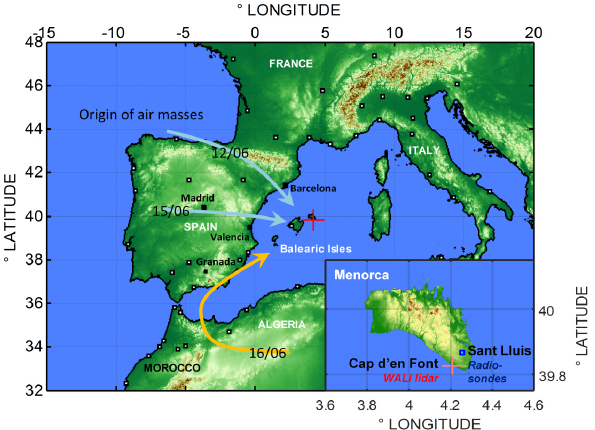
Figure 1. Situation map of the Menorca/Cap d’en Font station (red cross). The launch site of radiosoundings on Menorca island is shown as a blue square within the insert. Origins of air masses on the dates of lidar/radiosonde intercomparisons are noted as coloured ar- rows (Menorca digital elevation model courtesy of NASA/ASTER